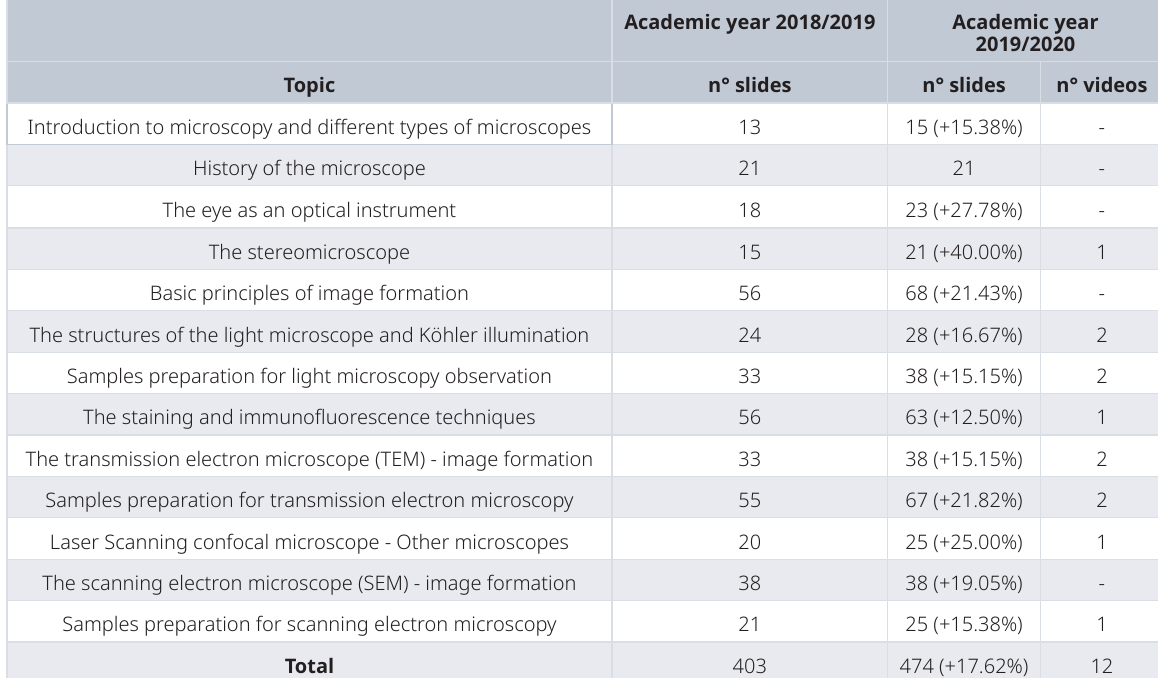
Table 1. Slides and videos for 2019/2020 academic year and percentage change compared to